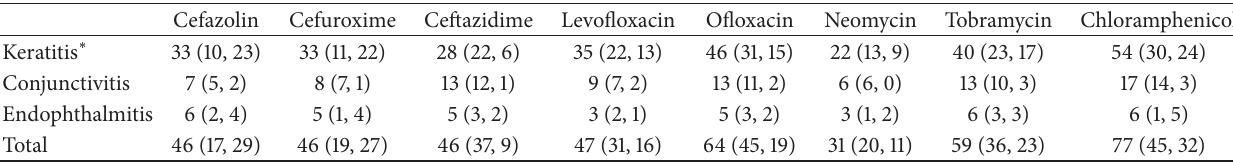
Table 3: The numbers of MDR strains resistant to eight